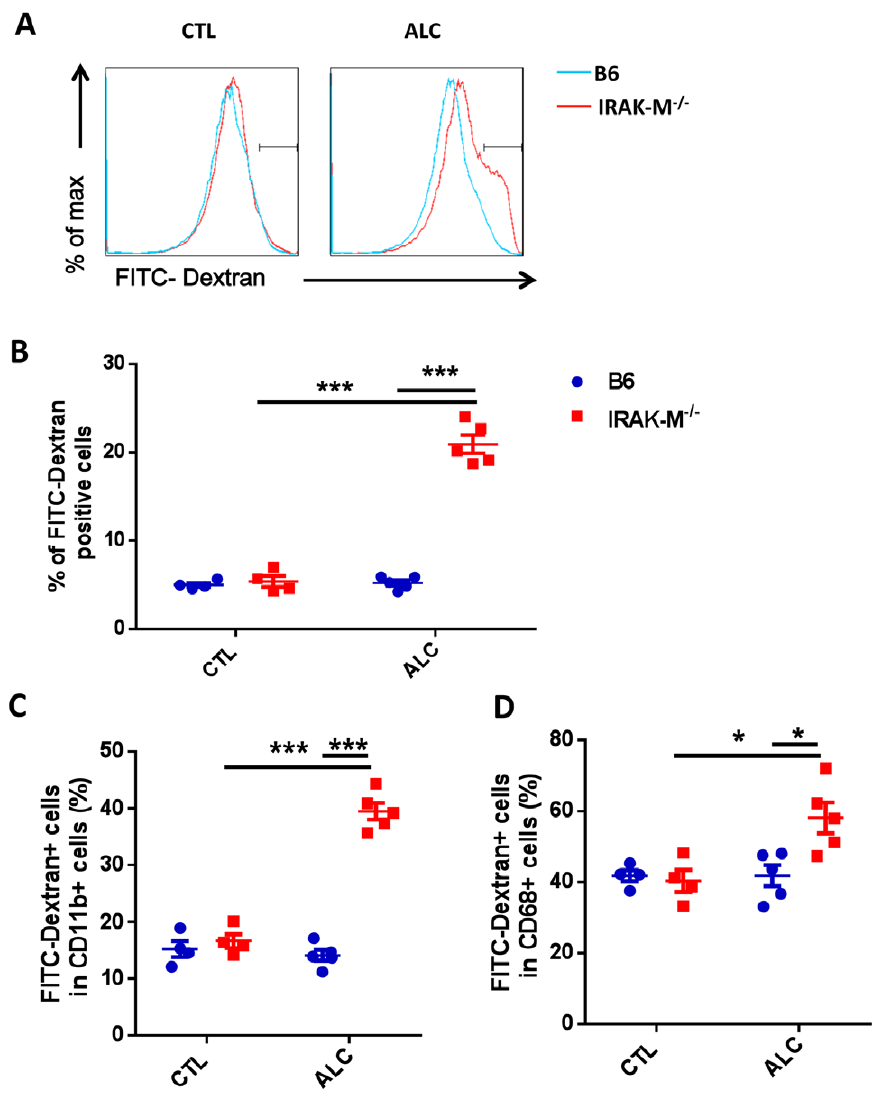
Figure 5. Phagocytic activity of Kupffer cells in liver after alcohol treatment. (A) Representative histogram of FITC-dextran intake LMNCs in wild type B6 mice (blue line) and IRAK-M 2 / 2 mice (red line, 2%). (B) FITC-dextran uptake by LMNCs in wild type B6 (blue) and IRAK-M 2 / 2 mice (red, 23%). (C) FITC-dextran uptake by CD11b + Kupffer cells in wild type B6 (blue) and IRAK-M 2 / 2 mice (red). (D) FITC-dextran uptake by CD68 + Kupffer cells in wild type B6 (blue) and IRAK-M 2 / 2 mice (red). Experiments were performed 3 times. N=3–4 in each group of each experiment. The data presented are from one of the 3 experiments. Error bars represent the SD of samples within a group. * P , 0.05, ** P , 0.01, *** P , 0.001, Two way ANOVA